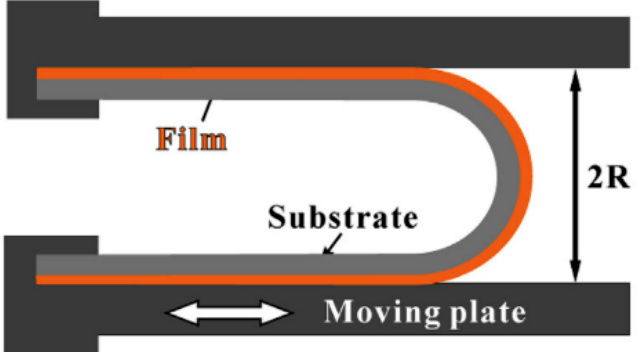
Figure 13. Schematic illustration of cyclic bending test system. Adapted from [37,74,91,96].